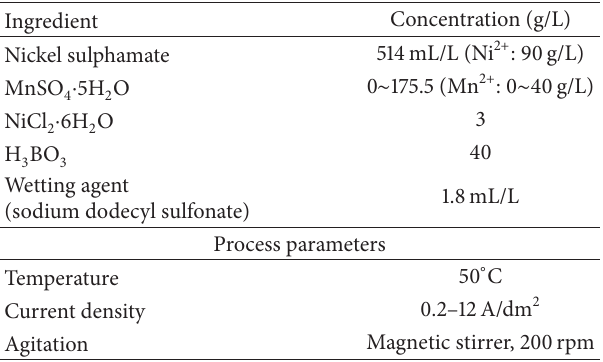
Table 1: Compositions of electrolyte and the associated process